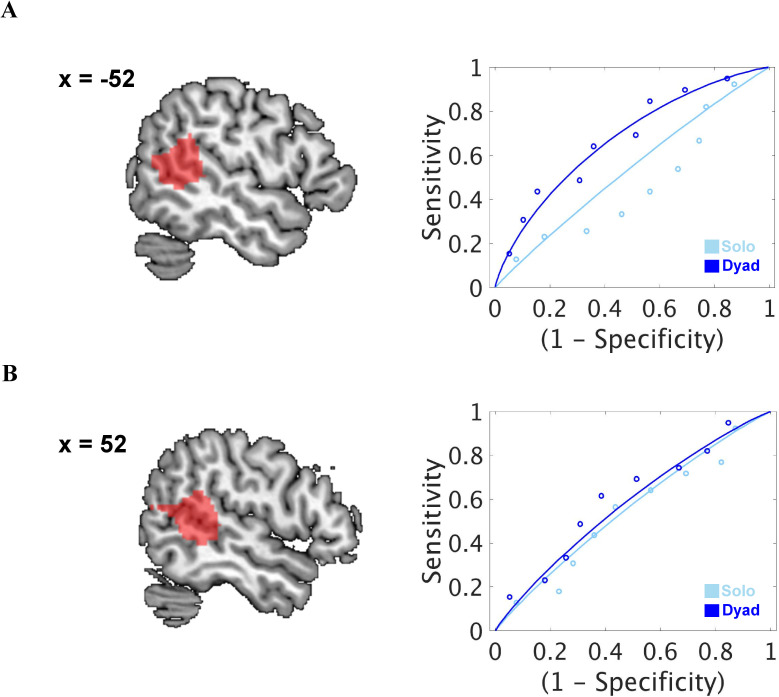
Results of decoding analyses using decision-related multivoxel neural patterns of (A) the left and (B) the right temporoparietal junction/posterior superior temporal sulcus (TPJ/pSTS).The regions of interest of TPJ was defined based on a whole-brain parcellation map from the Neurosynth database. The receiver operating characteristic curve showed a trend that the decision-related multivoxel neural patterns of either side of the TPJ can slightly better distinguish the Bribe condition (two-choice forced-alternatives decoding accuracy ± SE of Dyad Bribe (DB) vs. Dyad Control (DC): left TPJ/pSTS: 64.1 ± 10.3%; right TPJ: 61.5 ± 9.9%) from the Control condition in the Dyad scenario than the Solo scenario (Solo Bribe [SB] vs. Solo Control [SC]: left TPJ/pSTS: 38.5 ± 6.2%; right TPJ/pSTS: 59.0 ± 9.4%). However, none of these decoding tests reached statistical significance (DB vs. DC: left TPJ/pSTS: p=0.108; right TPJ/pSTS: p=0.200; SB vs. SC: left TPJ/pSTS: p=0.200; right TPJ/pSTS: p=0.337). .